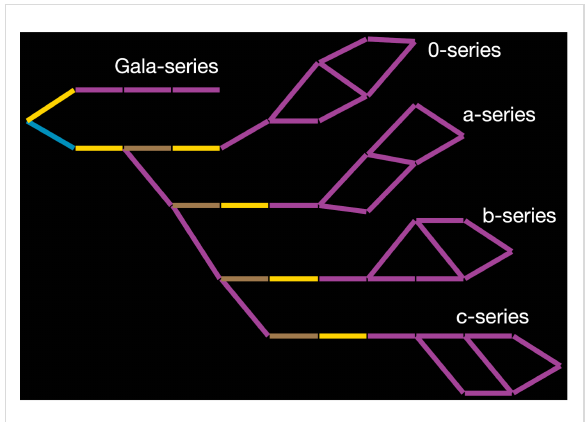
Figure 4: Ganglioside biosynthetic reaction network predicted by the Glycologue enzyme simulator. Starting from ceramide, which is the root (leftmost) node, 41 carbohydrate structures are predicted using 10 enzymes. The edges of the graph represent enzyme reactions, colored according to the type of sugar transferred: yellow (galactosyl- transferases); blue (glucosyltransferases); brown ( N -acetylgalac- tosaminyltransferases); magenta